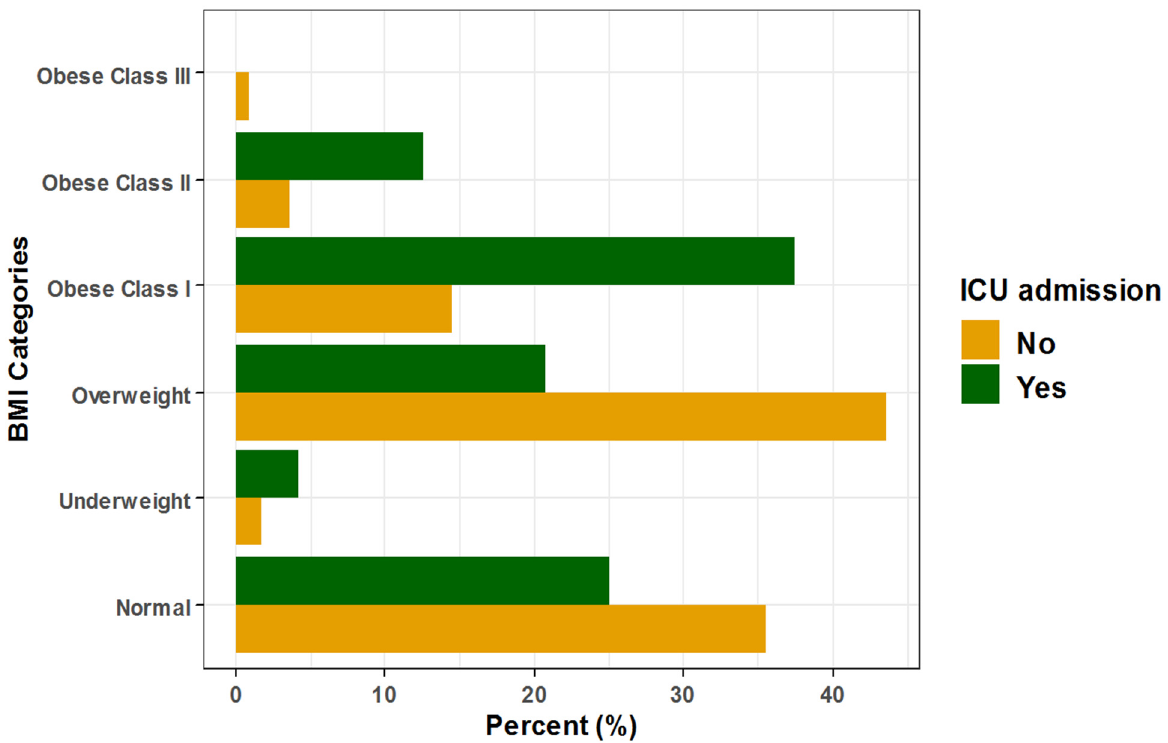
Figure 3. Association between BMI and ICU admission among hospitalized COVID-19 patients. Table 4. Relationship between patient BMI and ICU admission among COVID ‐ 19 patients. Table 5. Relationship between patient BMI and the radiological findings of